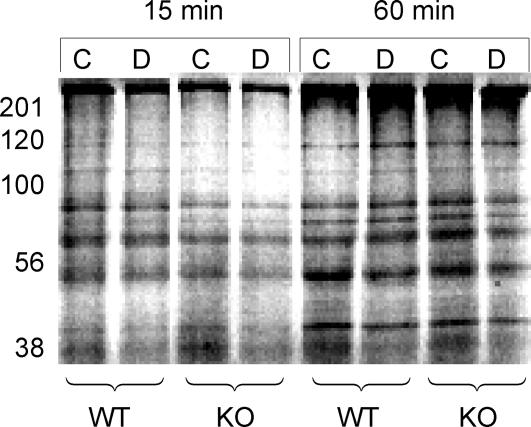
SNs Prepared from WT and fmr-1 KO Cortices Are Translationally ActiveSDS-PAGE analysis of 35S-Met–labeled SNs without (C lanes) or with (D lanes) DHPG stimulation for times shown in minutes. The data are representative of multiple experiments: n = 6 (WT); n = 5 (KO).